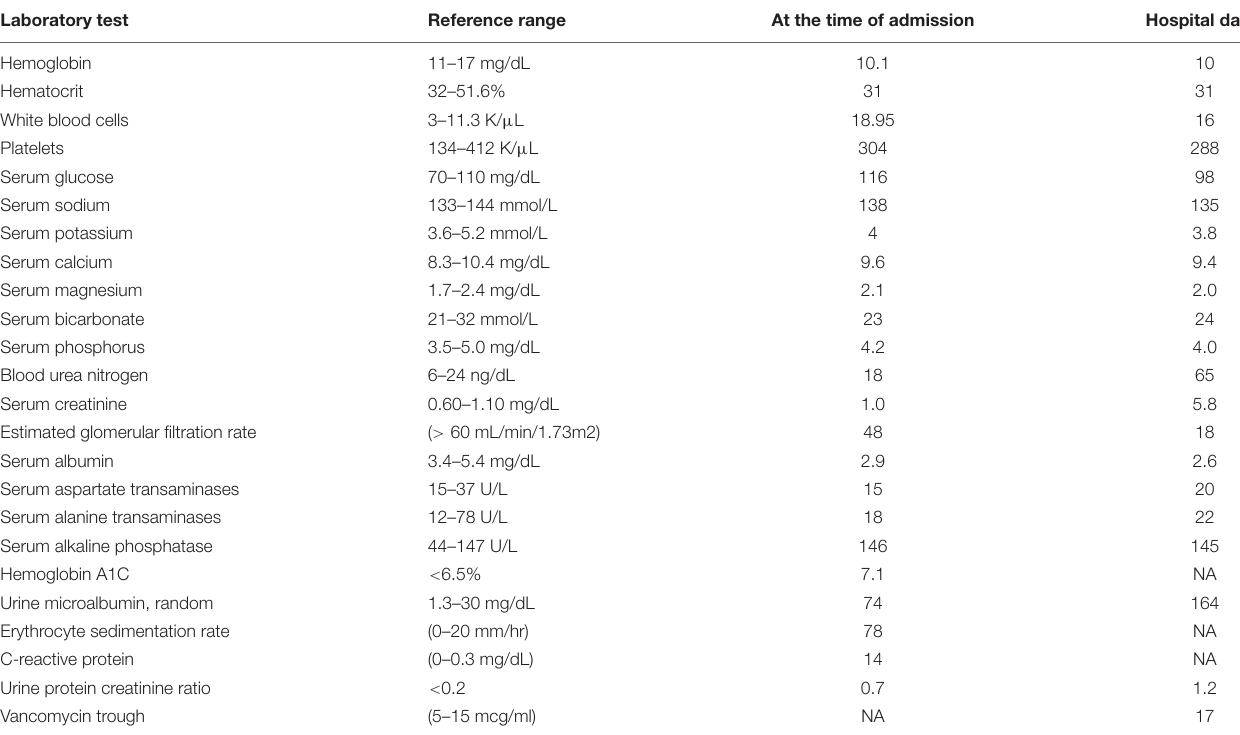
TABLE 1 | Laboratory work-up at the time of admission and on hospital day 4. Laboratory